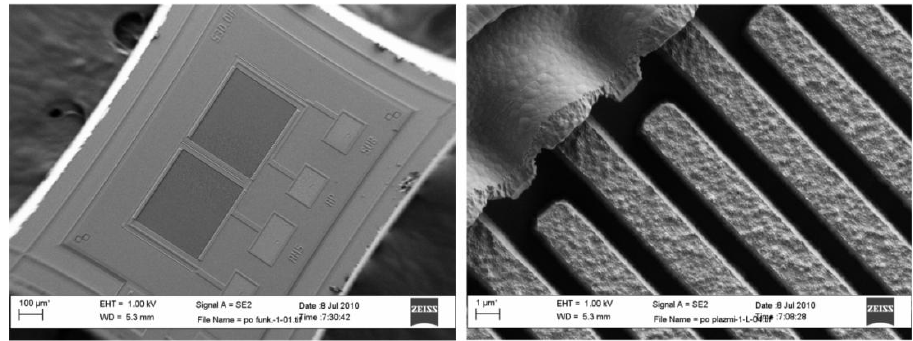
Figure 8. Scanning electron microscope (SEM) micrographs of a comb differential sensor. A pair of capacitors, forming the differential sensor is shown on the left and the detail of one comb capacitor is shown on the right.